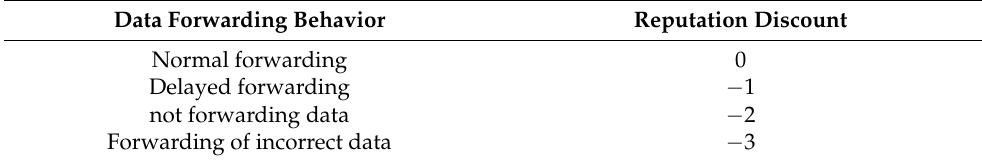
Table 2. Classification of data forwarding behavior and penalty rules. Data Forwarding Behavior Reputation Discount Normal forwarding 0 not forwarding data − 2 Forwarding of incorrect data −